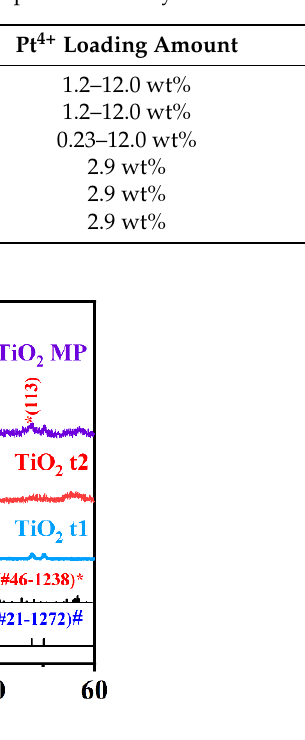
Table 1. Summary of the crystal structure of Pt deposited nanocrystals and the reaction conditions.